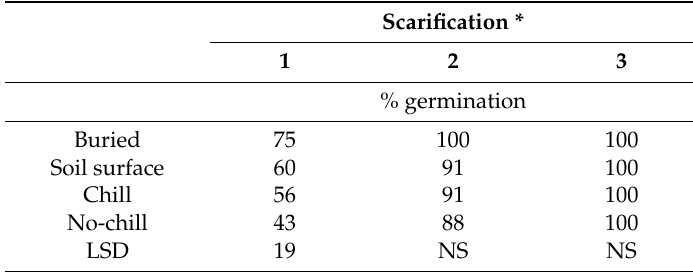
Table 2. Percentage germination of S. obtusifolia seeds from multiple maternal sources under various environmental